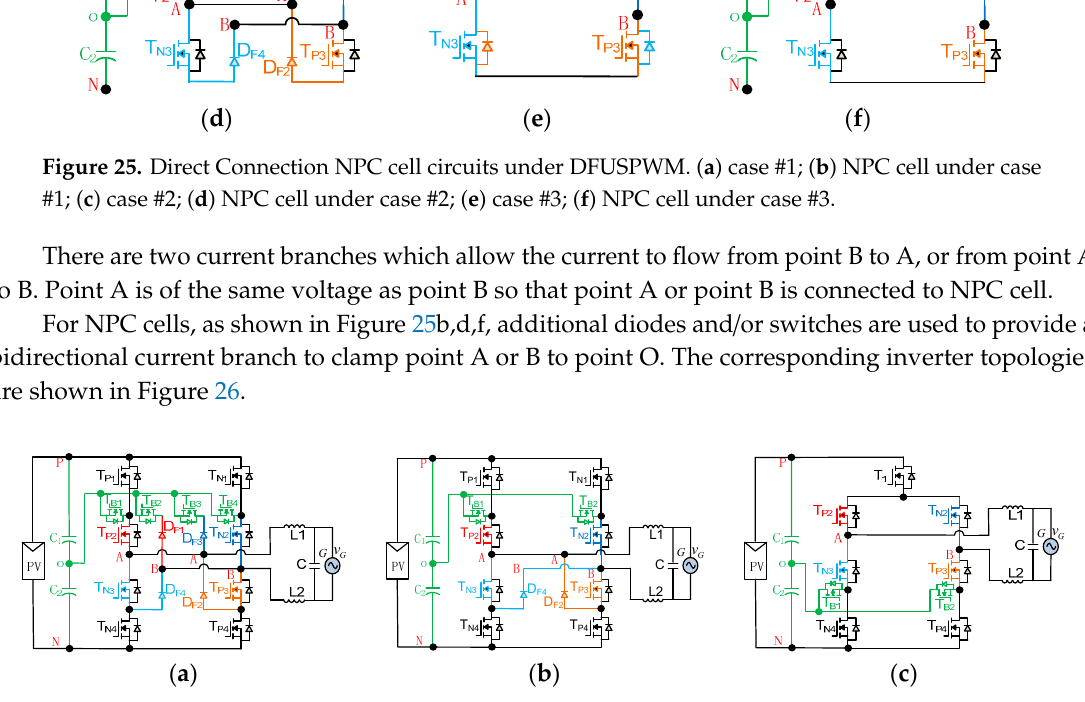
Figure 26. Inverter topologies with the Direct Connection NPC cell under DFUSPWM. ( a ) R11S2 (new); ( b ) R12S2 (new); ( c ) R13S2 (new).